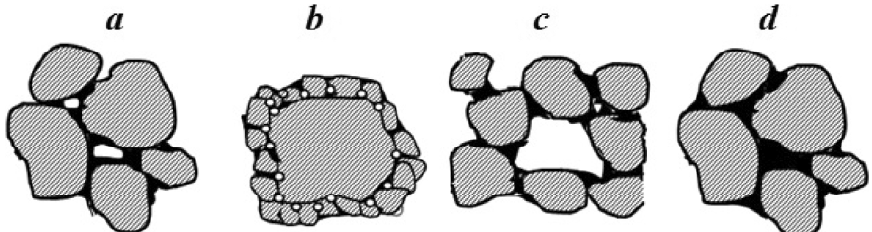
Fig. 4 . Capillary structures in disperse systems: a –three-phase grain, b/ - three-phase globule, C – cellu- lar-globular structure, d- two-phase grain (replotted regarding to the data from [45]).